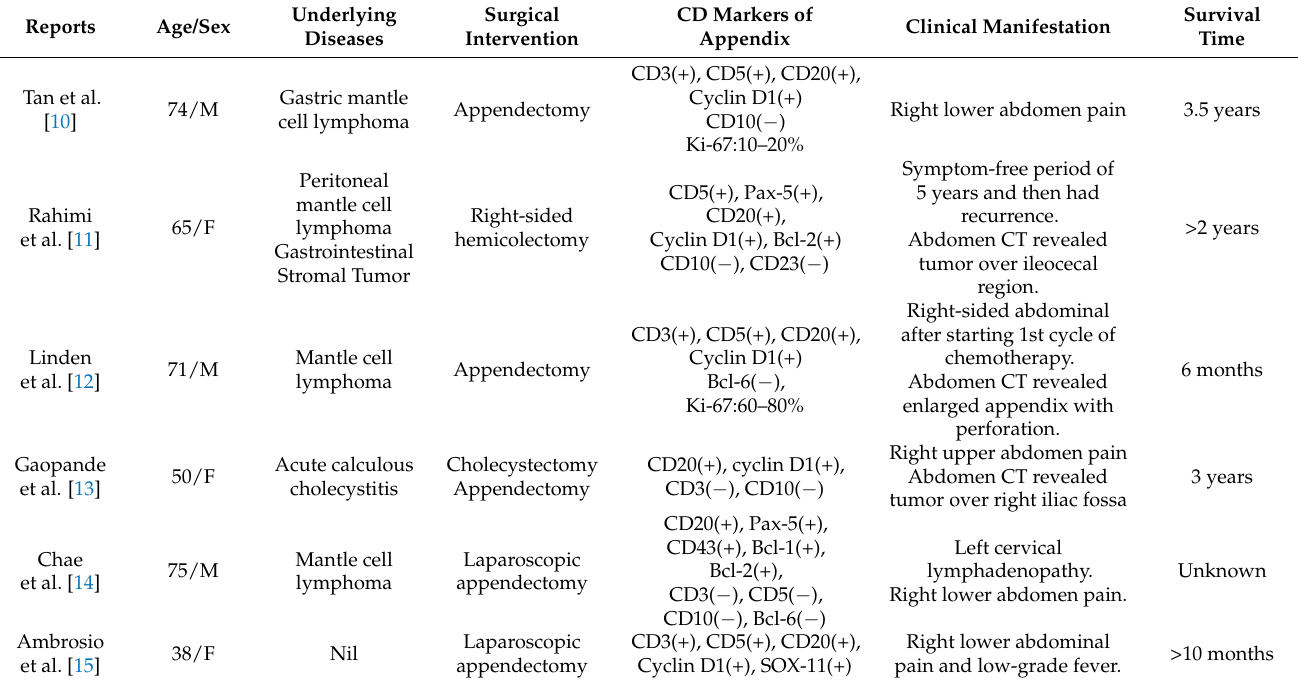
Table 2. Cases of mantle cell lymphoma with appendix